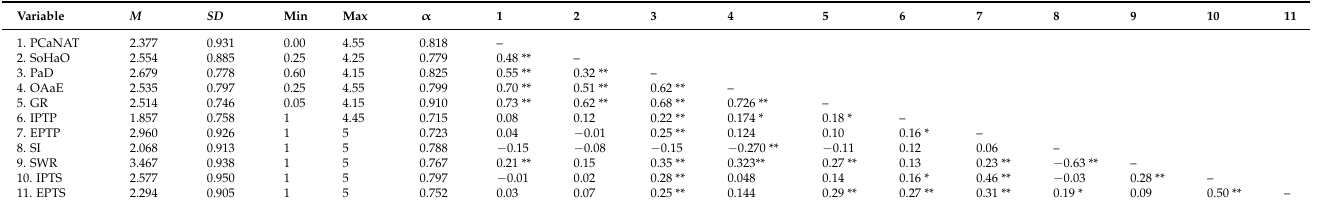
Table 1. Summary Statistics, Reliability, and Correlations between Study Variables ( N =